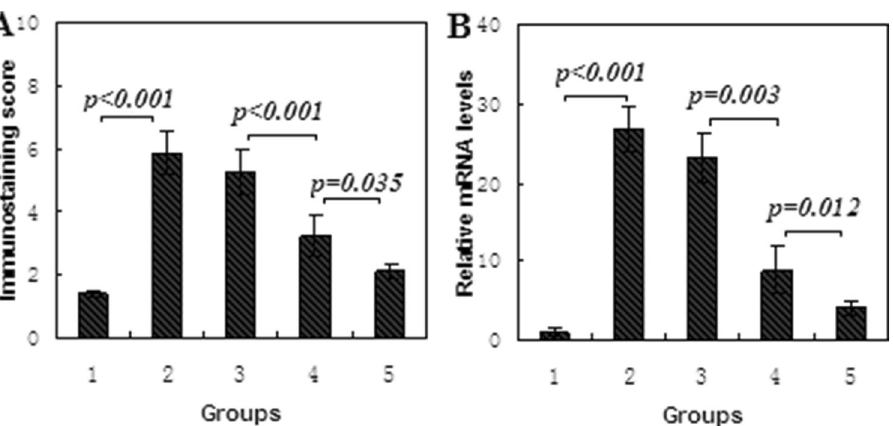
Figure 5. HMGB1 expression in sinonasal mucosa of rats from control, ARS and treatment groups. Data is presented as mean ± standard deviation. ( A ) Immunostaining score was assayed by immunohistochemistry; ( B ) mRNA level was detected by quantitative RT-PCR.